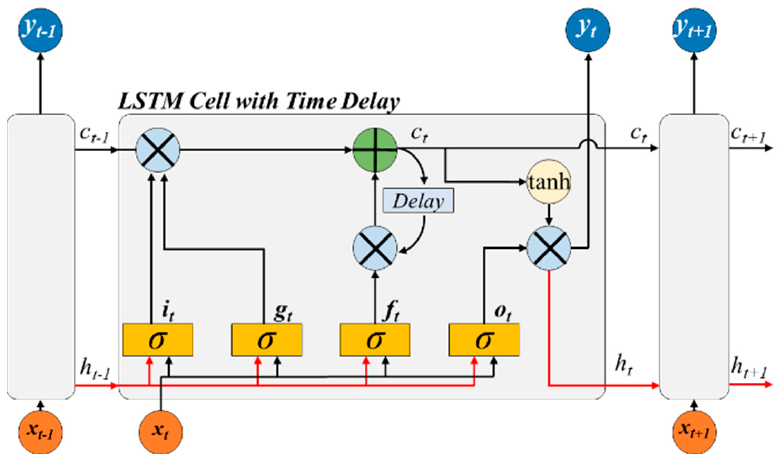
Figure 4. LSTM cell architecture.